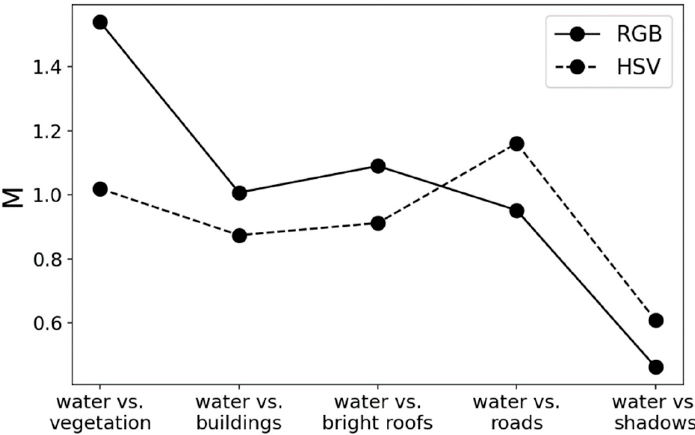
Figure 6. The M-statistic test of water and other land cover types in RGB and HSV color spaces, respectively.